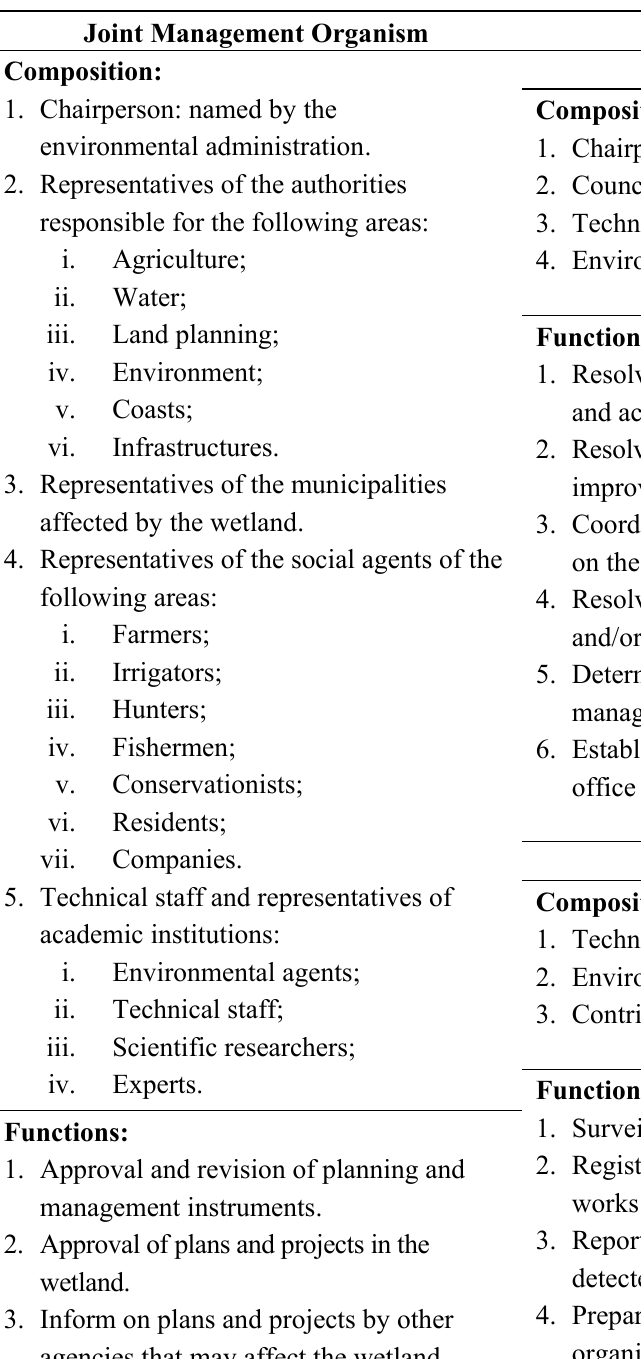
Table 5. Proposed management organisms: composition and